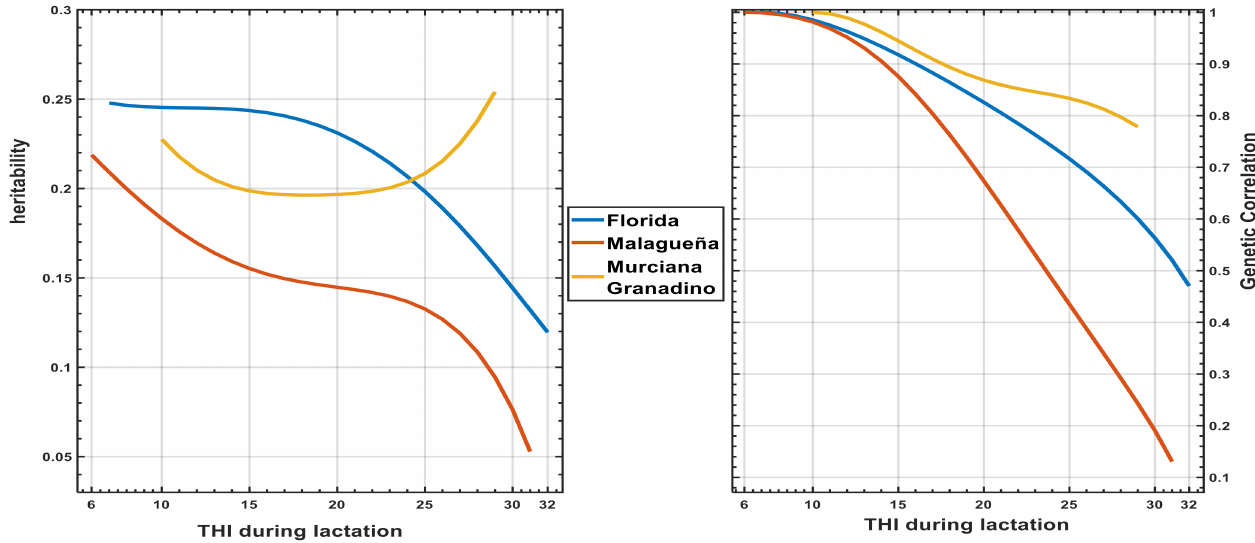
Figure 4. Variation along the THI trajectory during lactation in the estimates of heritability and genetic correlations for total fat and protein production yield obtained with RN model 2 in three Spanish dairy goats